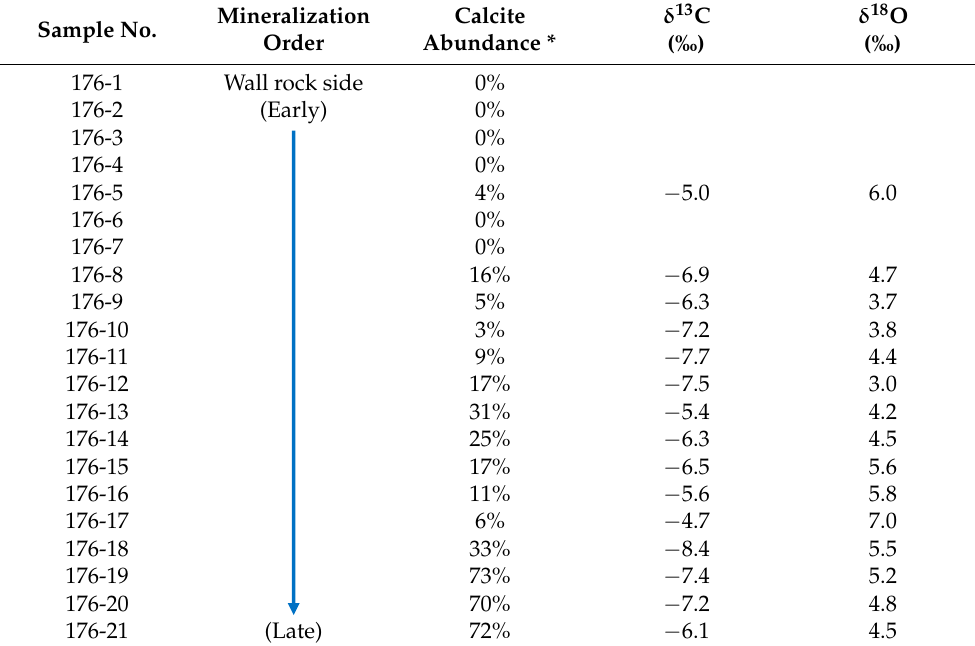
Table 3. Calcite abundance and isotope data of calcite-bearing 20100317 vein sample (0.9 mm-width sample set; Figure 4b,c). Sample